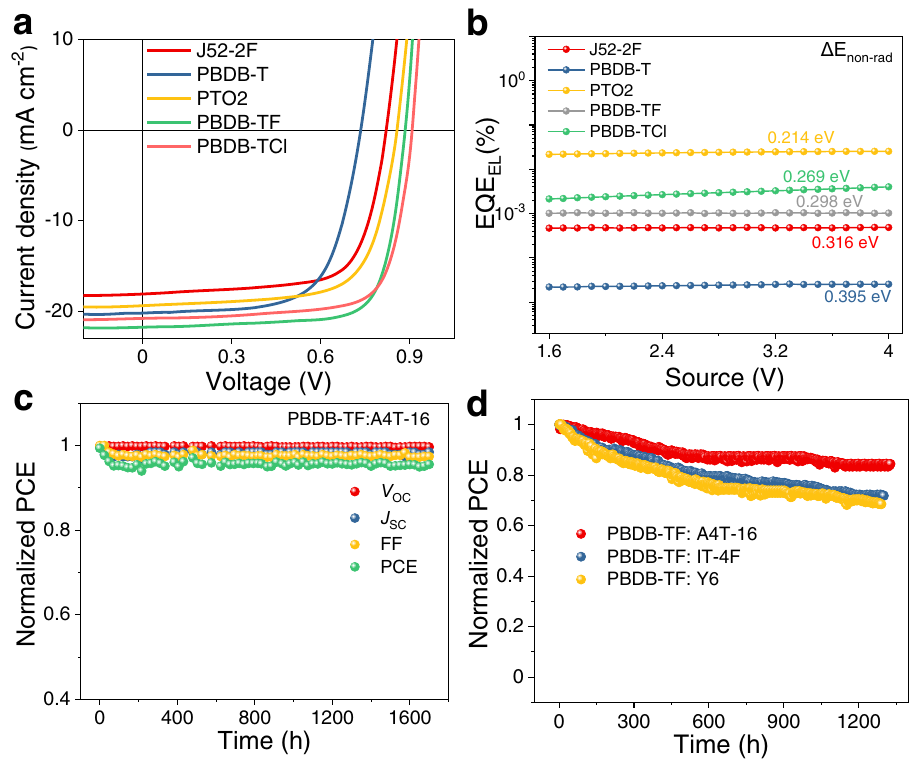
Fig. 7 Universality of A4T-16 and device stability. a J − V curves, b EQE EL curves of polymer donors: A4T-16-based cells. c The storage stability of the encapsulated PBDB-TF: A4T-16 cell (the encapsulated cells were stored in a glovebox under the nitrogen atmosphere). d Photo-stability of IT-4F-, Y6- and A4T-16-based cells (the encapsulated cells were measured in air under the illumination of AM 1.5 G, 100 mW cm − 2 at ~50 ± 3